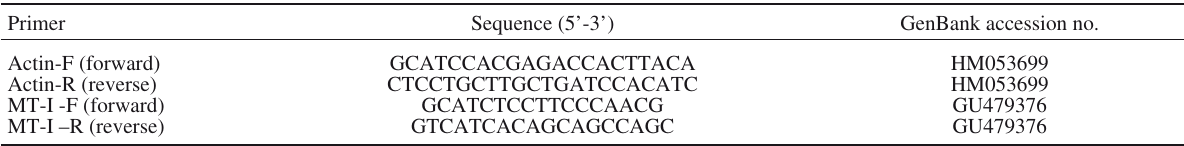
Table 1. – Sequences of the primers used in this